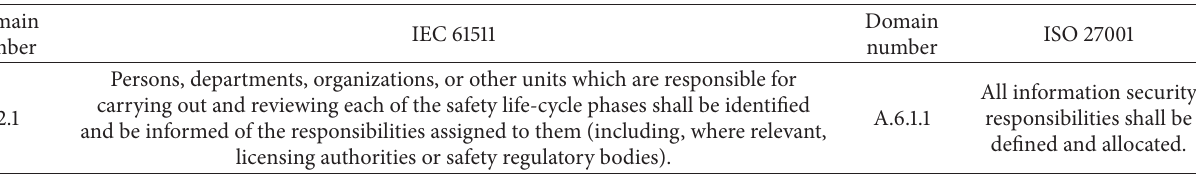
Figure 7: The matching for domains of international standards. Table 1: The example of security controls list up for international